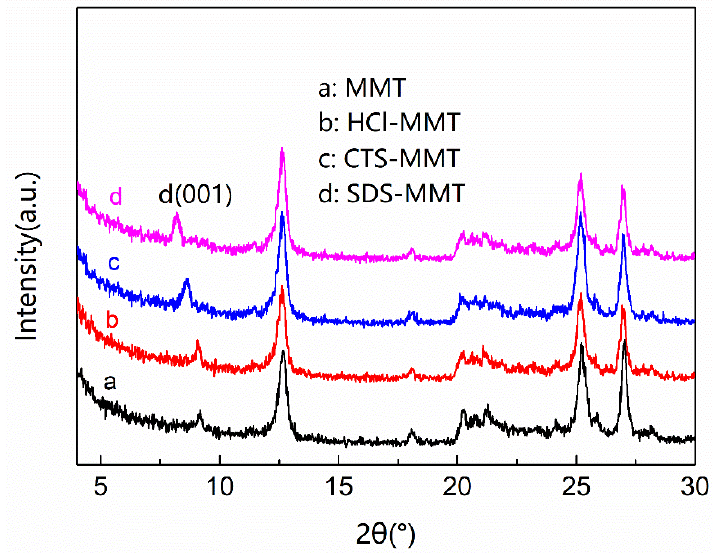
Figure 8. XRD diagram of MMT and modified MMT.